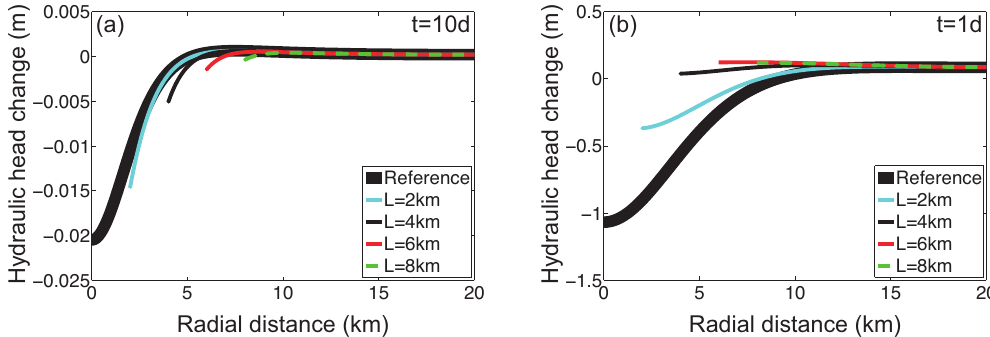
Figure 11. Influence of lateral distance L between chamber and aquifer on the hydraulic head change profile through the aquifer after t = 10d (pyroclastic aquifer) and t = 1d (lava flow aquifer), respectively. (a) pyroclastic aquifer, (b) lava flow aquifer.